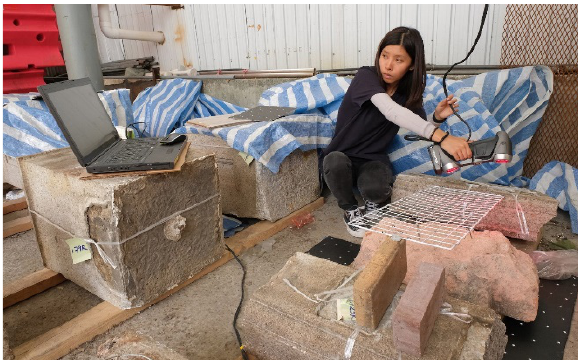
Figure 8: 3DSU using the portable 3D scanner to scan the large granite fragments at HyD’s store.